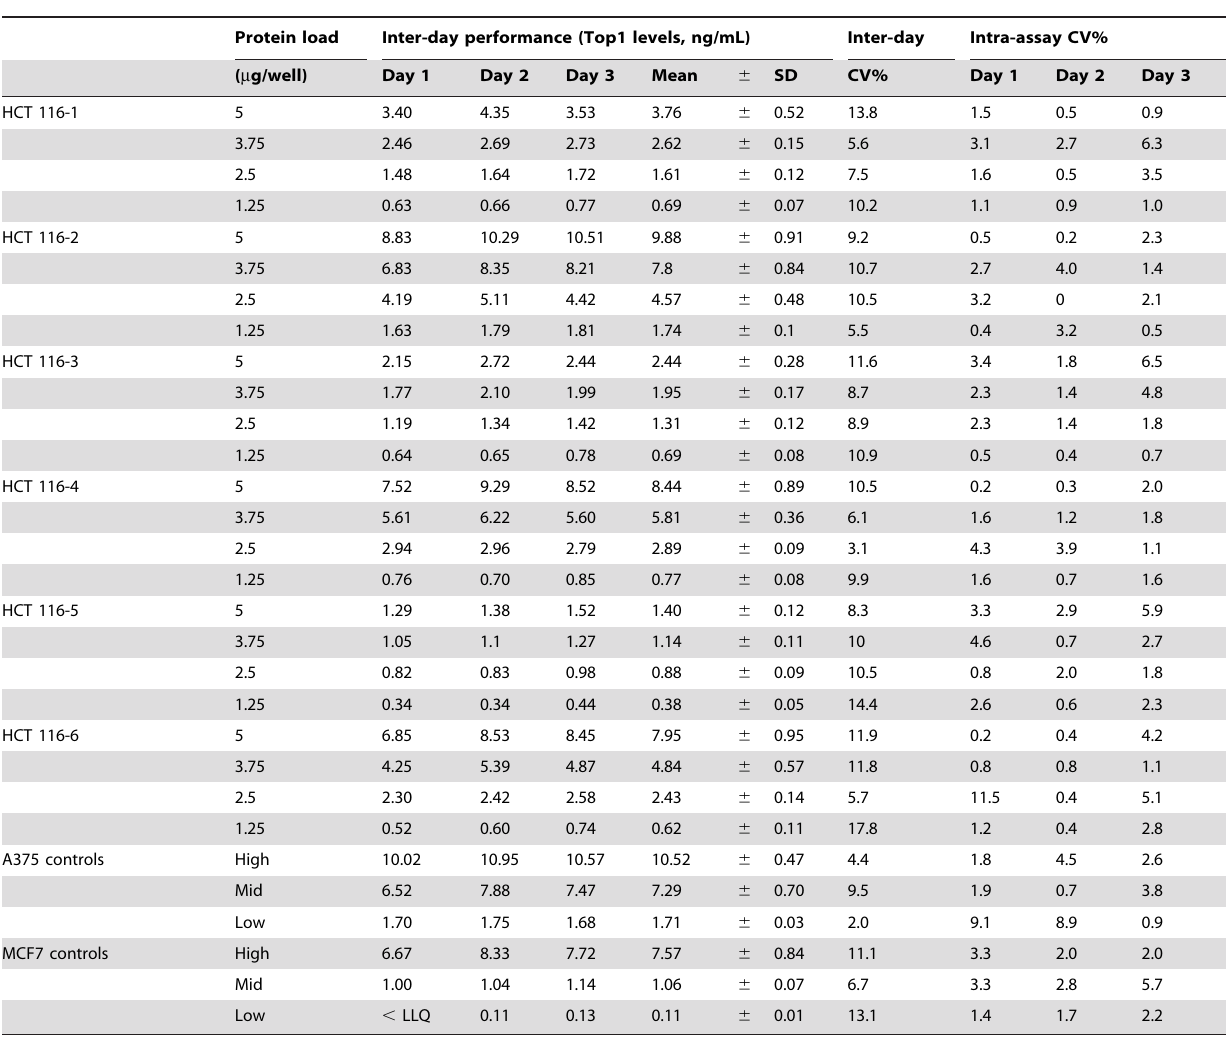
Table 2. Inter-day and intra-assay performance of the Top1